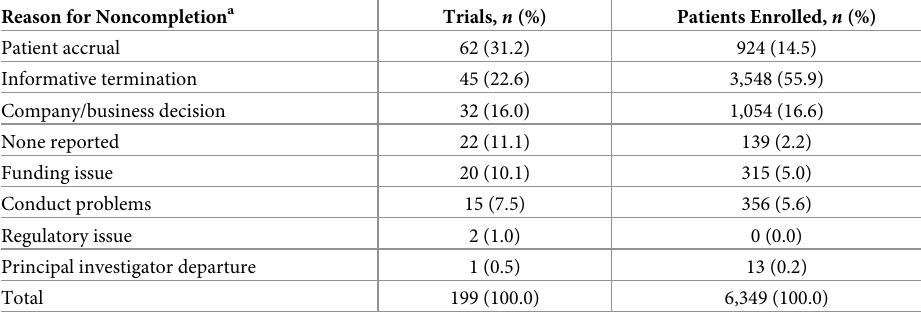
Table 3. Reasons for noncompletion of rare disease